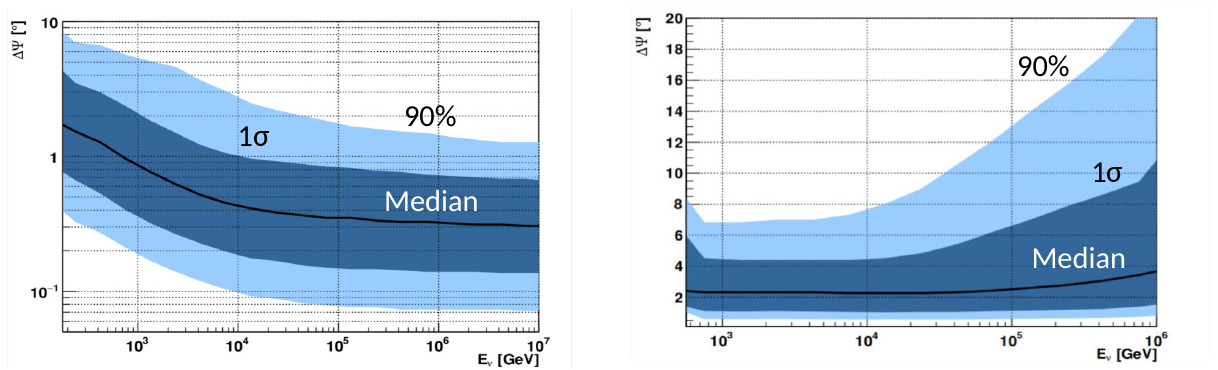
Figure 1. Median of the angle between the neutrino and the reconstructed muon track (left) and induced shower (right) directions for ANTARES for di ff erent neutrino energies [3, 4].